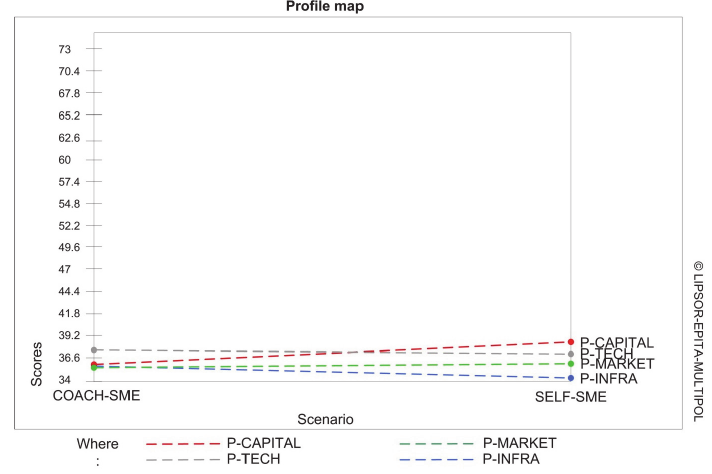
Fig 5. Profile Map for Policy Against Scenario